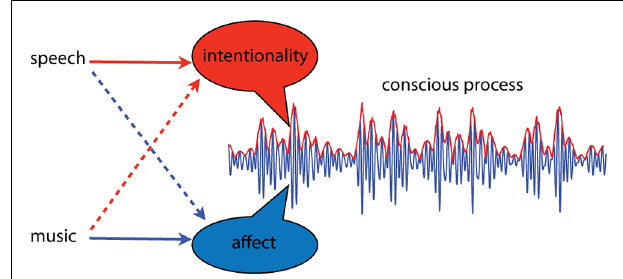
FIGURE 1 |A conscious process is conceived as a dynamic pattern of activity. Intentionality and affect are conceived as separable aspects of such processes, and different types of communication sounds may convey more of one or the other. Language primarily communicates